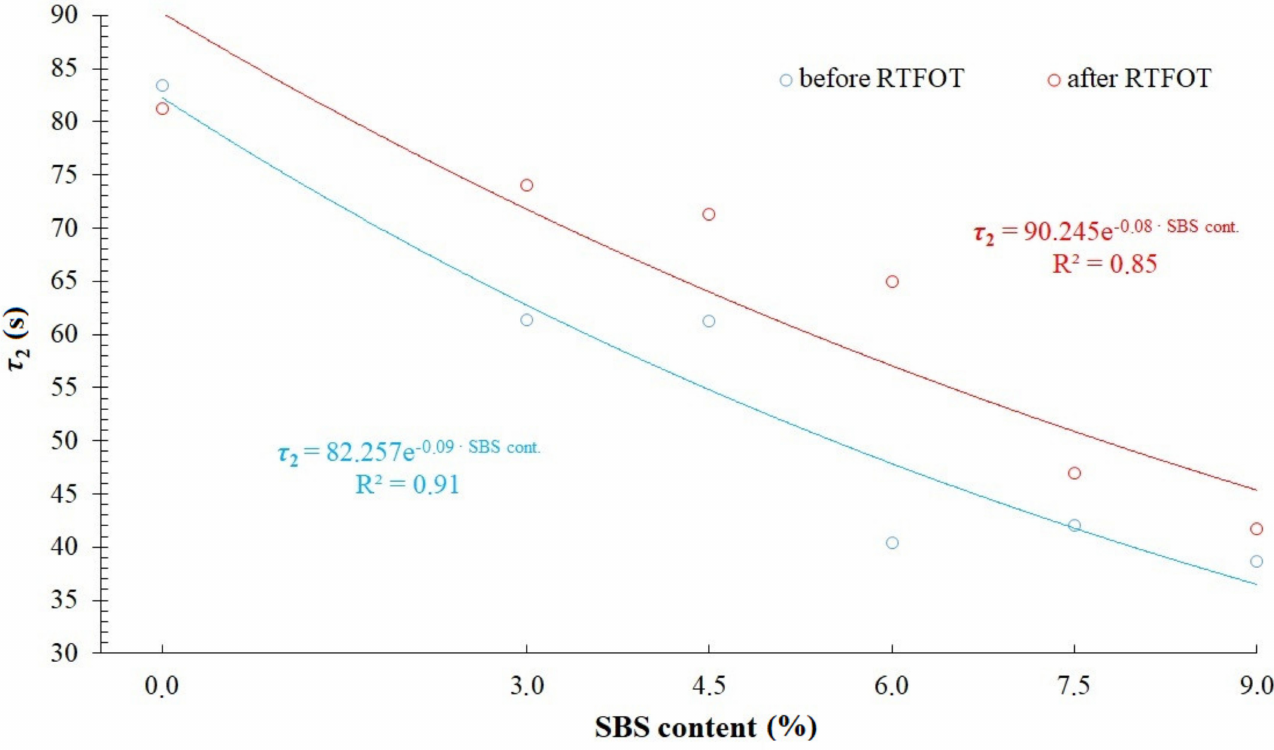
Figure 15. Relaxation time τ 2 = η 2 / E 2 in modified generalized Maxwell model with four